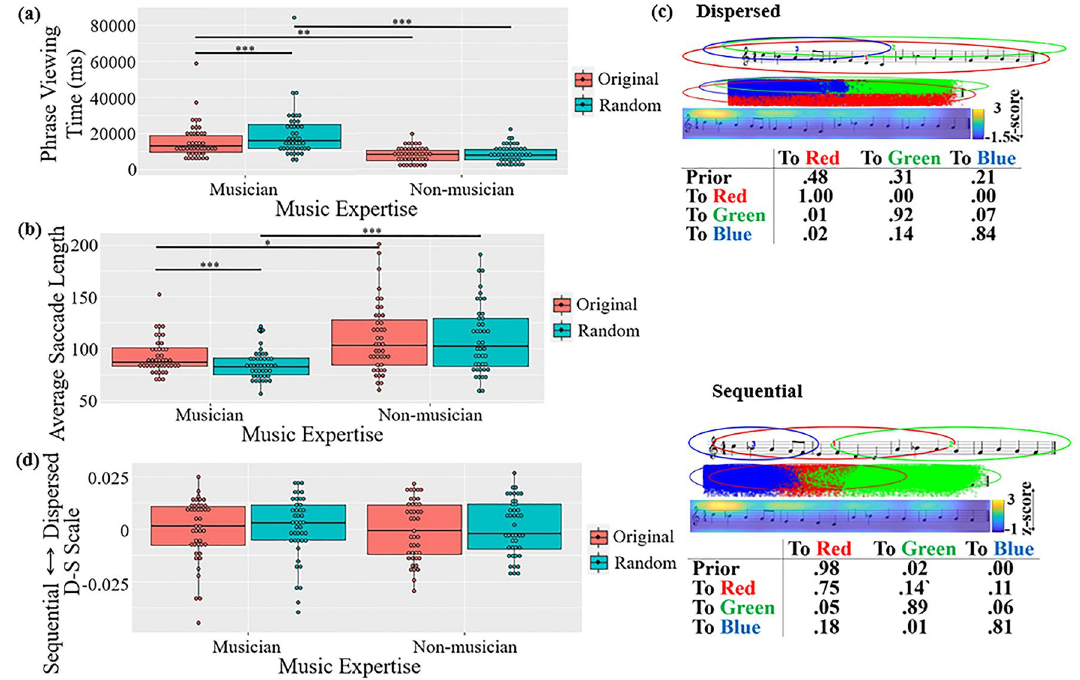
Figure 4. Results of the musical phrase viewing task: ( a ) Viewing time. ( b ) Average saccade length. ( c ) Two common patterns discovered using EMHMM. ( d ) Eye movement pattern measured in D-S scale (*** p < .001, ** p < .01, * p <